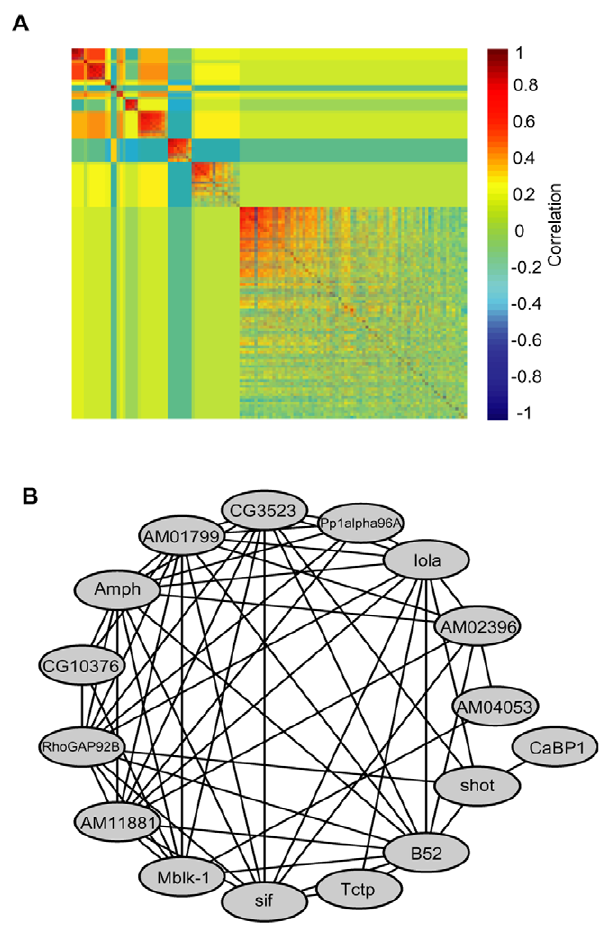
Figure 4. Gene networks associated with retinue response. Gene networks were constructed based on a gene-gene correlation matrix. The colors on the off-diagonal represent the average cross-module absolute correlations. GO analysis identified unique biological or molecular functions for many of these gene networks (Table S3). A . From the 960 genes associated with retinue response, 12 genetic modules were identified using MMC with an average |r|=0.37. B . Retinue response module 1 is a statistically-predicted gene network associated with retinue response that contains an overrepresentation of genes involved in axonogenesis. Each node depicts one of the transcripts associated with module 1, and each line represents a statistical correlation between the connected